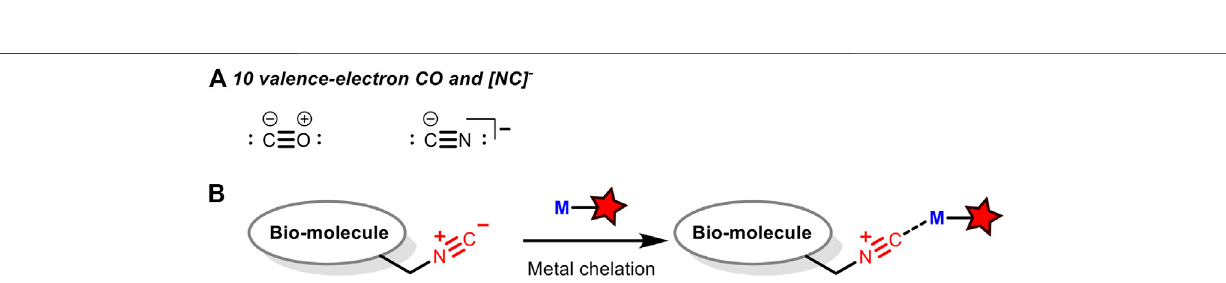
Frontiers in Chemistry |